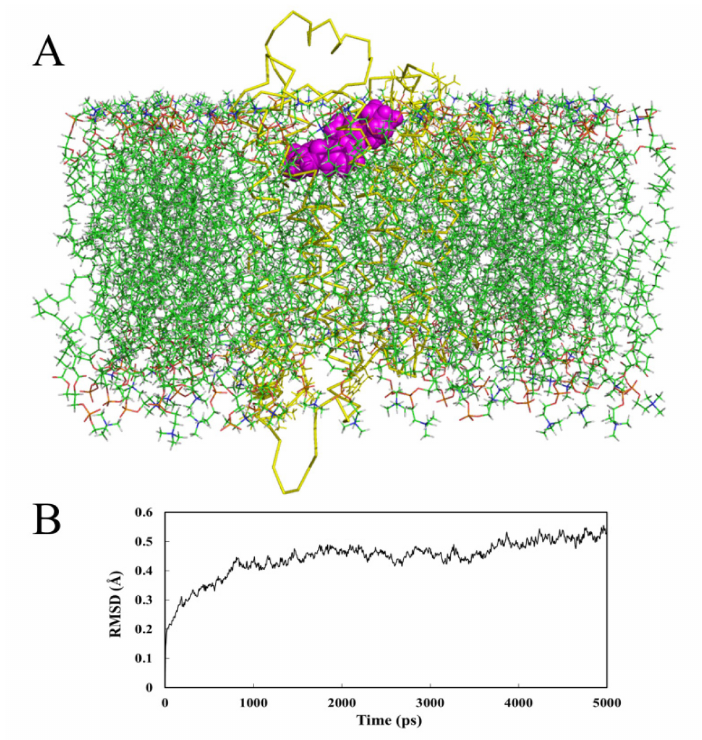
Figure 8. ( A ) The receptor with docked ligand within the lipid bilayer after 5 ns of MD simulation. Protein is shown as ribbons. Ligand is shown as spheres. Lipid molecules are shown as lines; ( B ) Plot of RMSD of docked complex versus the MD simulation time in the MD-simulated